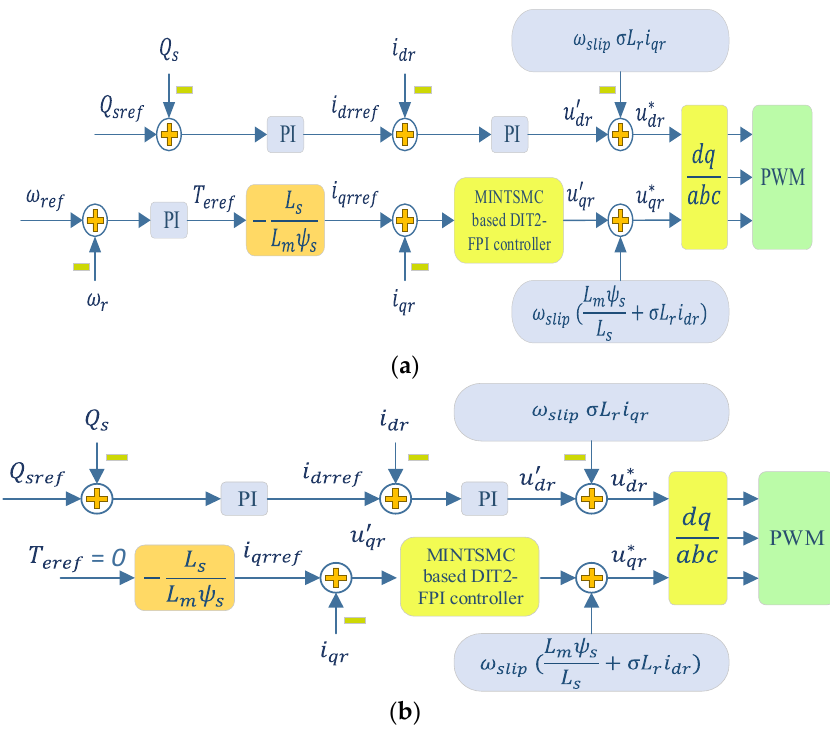
Figure 3. The control structure of the RSC in ( a ) normal operation, and ( b ) during a grid fault.